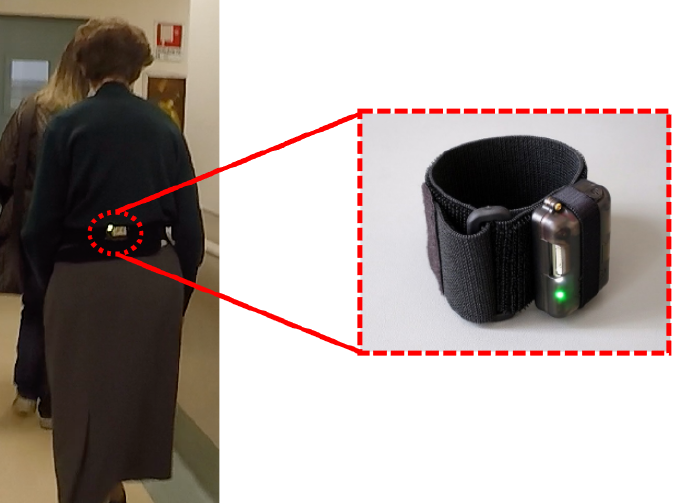
Figure 1. The used inertial wearable sensor and its position on the subject’s lower back.